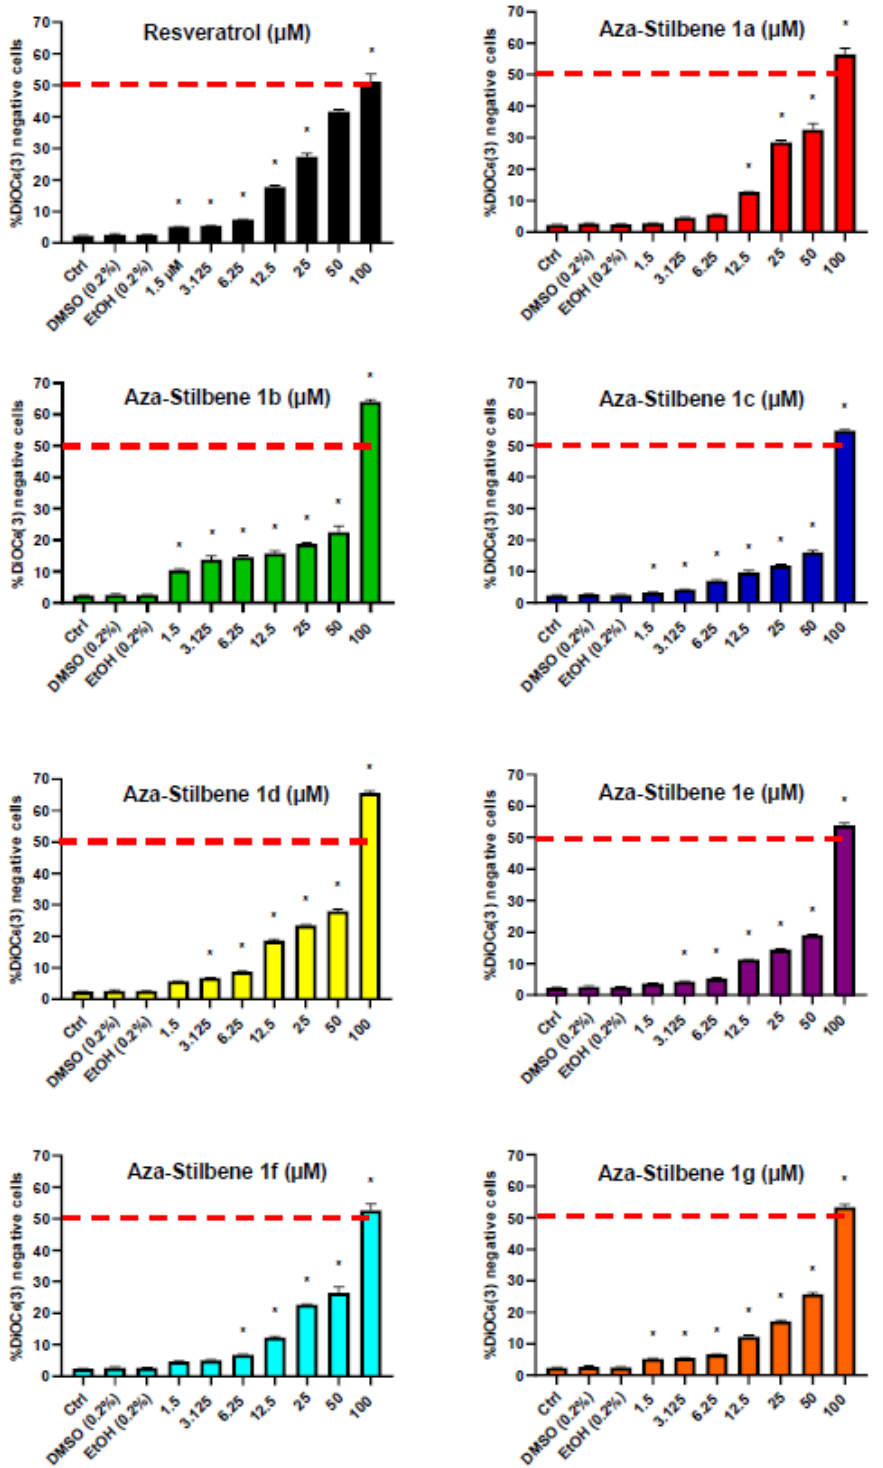
Figure 5. Flow cytometric evaluation of transmembrane mitochondrial potential ( ∆Ψ m) with DiOC6(3) under treatment with resveratrol and aza-stilbenes 1a to 1g . N2a cells were incubated for 48 h with or without resveratrol or aza-stilbenes 1a to 1g in a range of concentrations from 1.5 to 100 µ M. Data are the mean ± SD of two independent experiments performed in triplicate. Significance of the differences between control (untreated cells), Resveratrol ( trans -resveratrol) or aza-stilbenes 1a to 1g –treated cells; Student’s t test: * p < 0.05 or less.